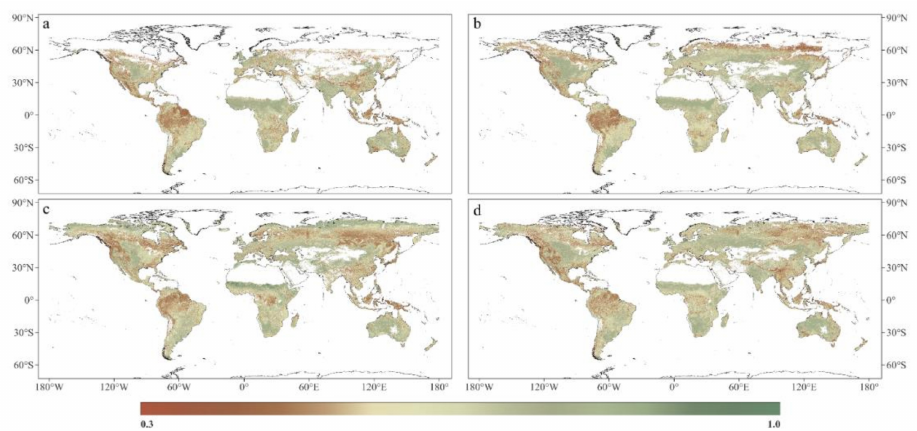
Figure 4. Global monthly CI in ( a ) January, ( b ) April, ( c ) July, and ( d ) October, aggregated from 2000 to 2020.